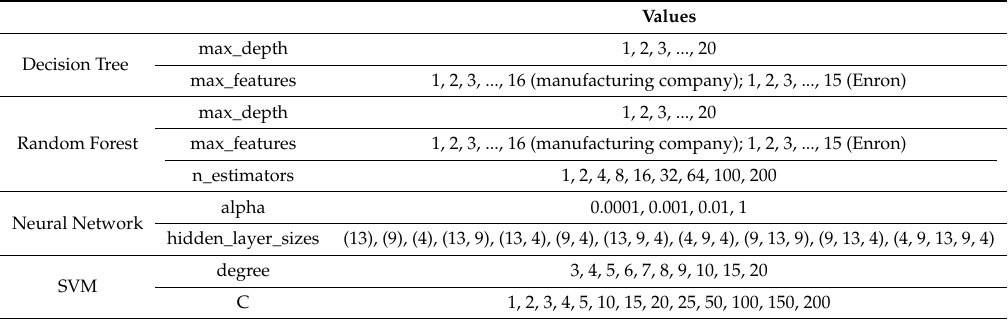
Table A21. Hyperparameter search space for supervised learning algorithms.